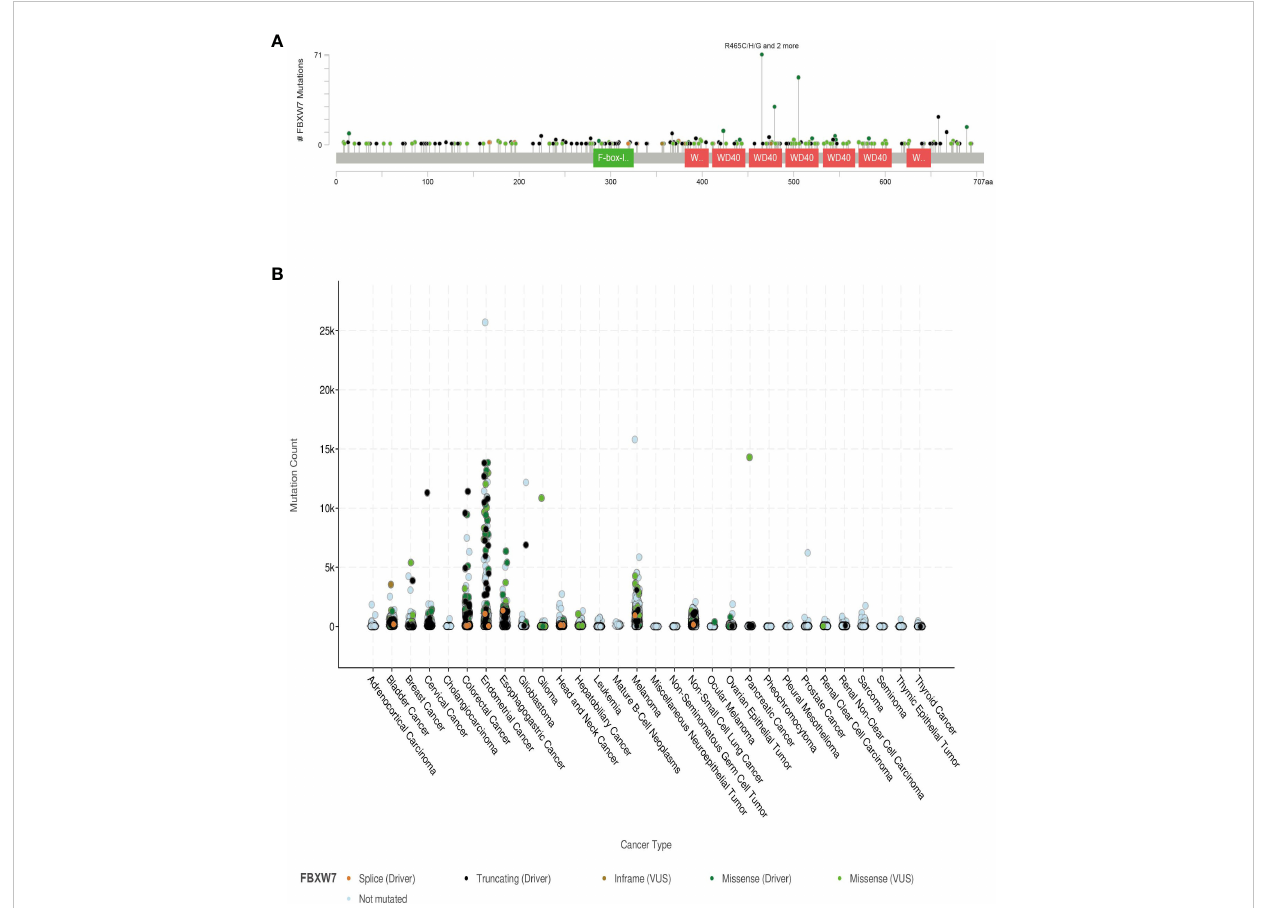
FIGURE 2 The situation of FBXW7 mutation is performed using cBioportal on the TCGA database (http://www.cbioportal.org/) (A) Mutation sites of FBXW7 and their mutation types. Different colors of spots indicate mutation types. Green spots represent missense mutation; black spots represent truncating mutation; brown spots represent splice mutation; purple spots represent struction variation or fusion mutation. (B) Mutation counts of FBXW7 in various cancer types. The color of these dots represent various type of mutation. This coordinate axis shows 30 types of